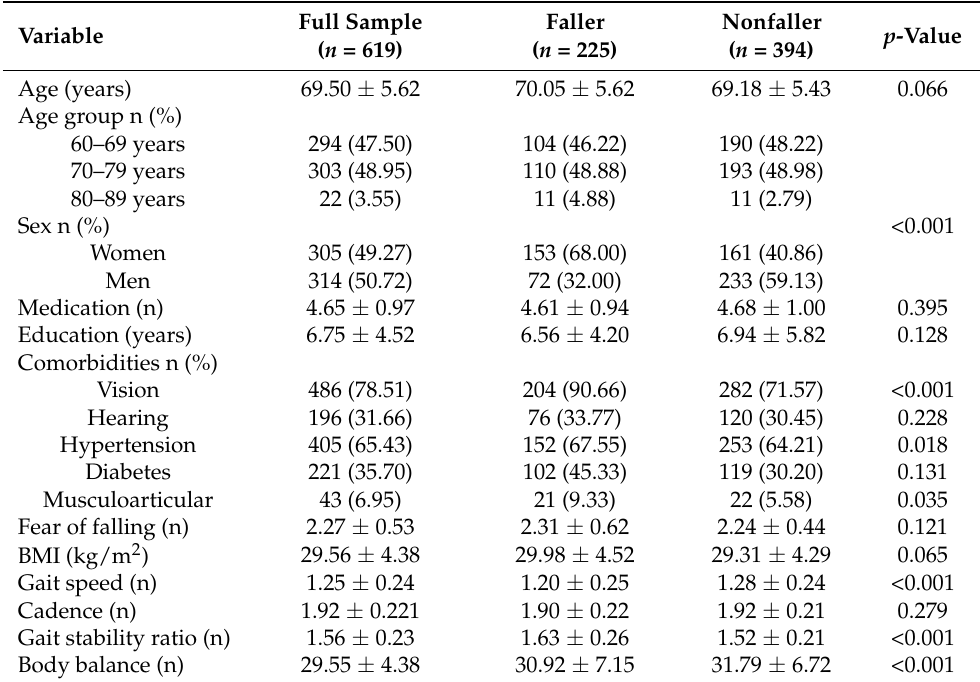
Table 1. Main characteristics of the